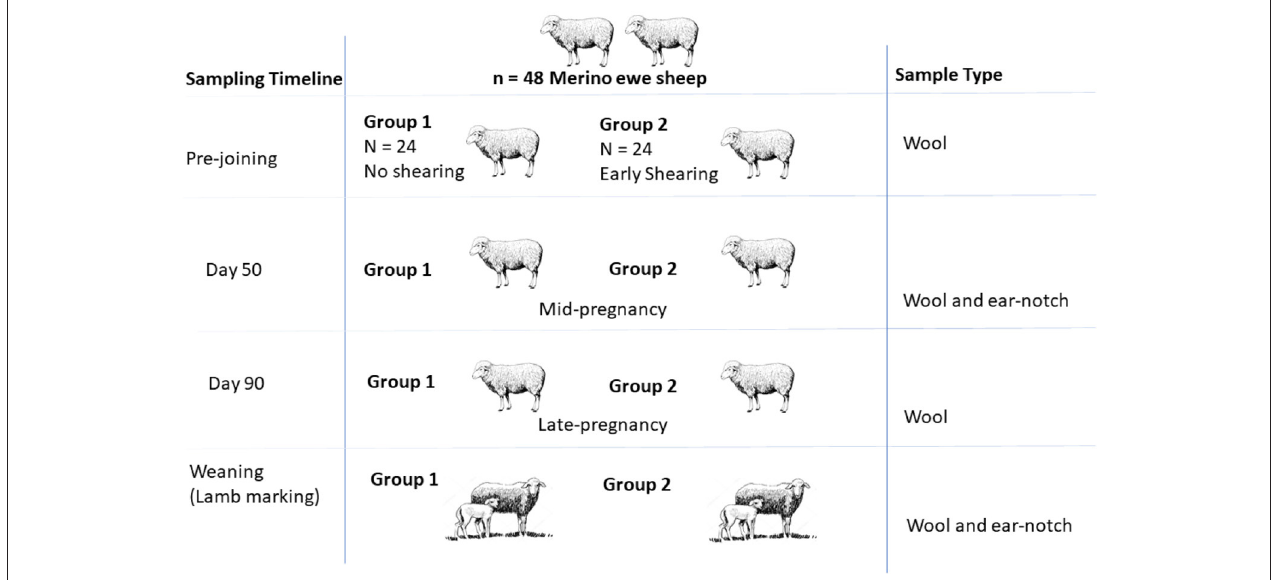
FIGURE 1 | Illustration summarizing the field sampling design presented with the sampling timeline, groups, and sample types.